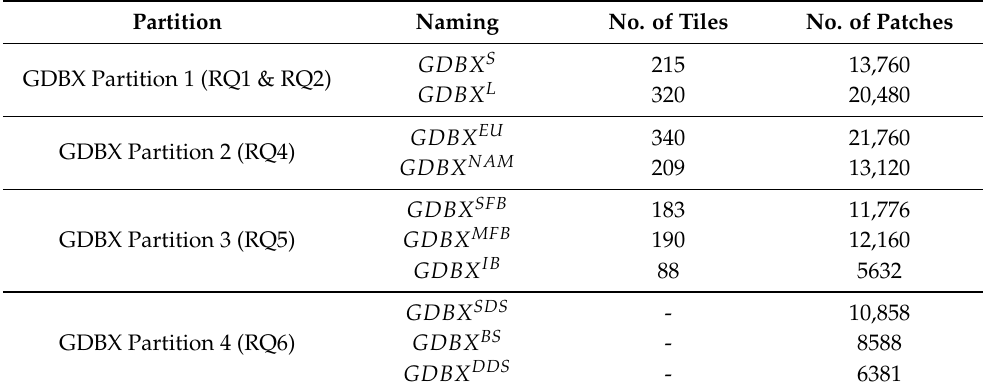
Table 3. Overview of the different partitions of the GDBX dataset necessary to answer the individual research questions. GDBX Partition 4 has been performed directly on a patch level, all others on a tile level. Note that for answering RQ3 (transfer learning), we employ the publicly available datasets INRIA and ISPRS (not listed